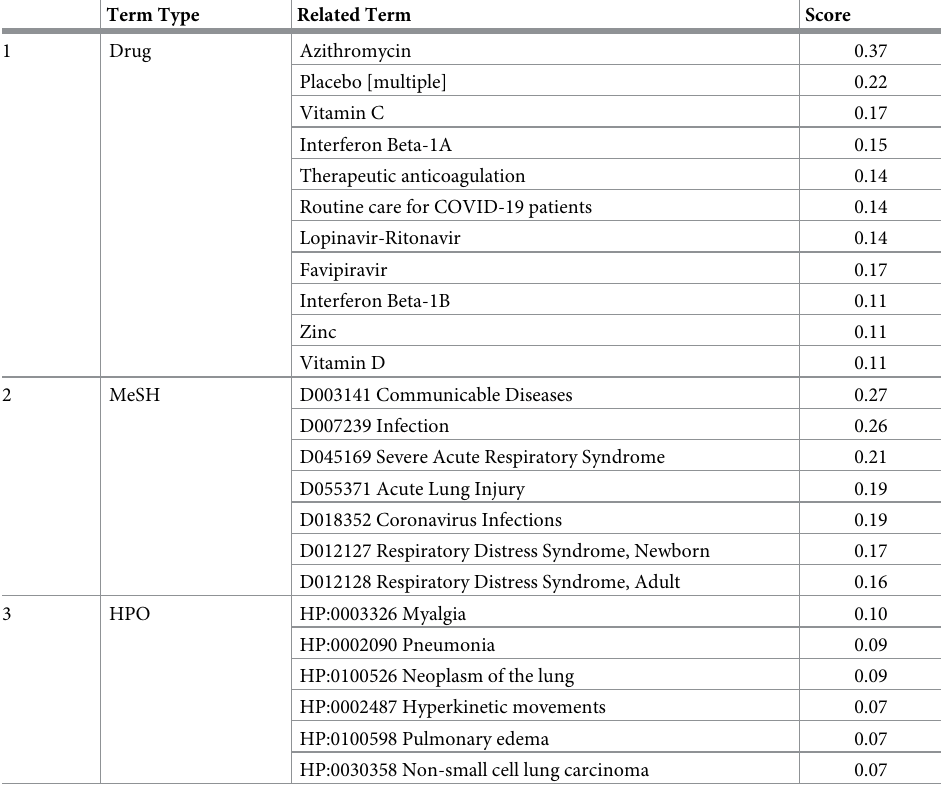
Table 2. Related drugs, MeSH, and HPO terms using co-occurrences with drug: